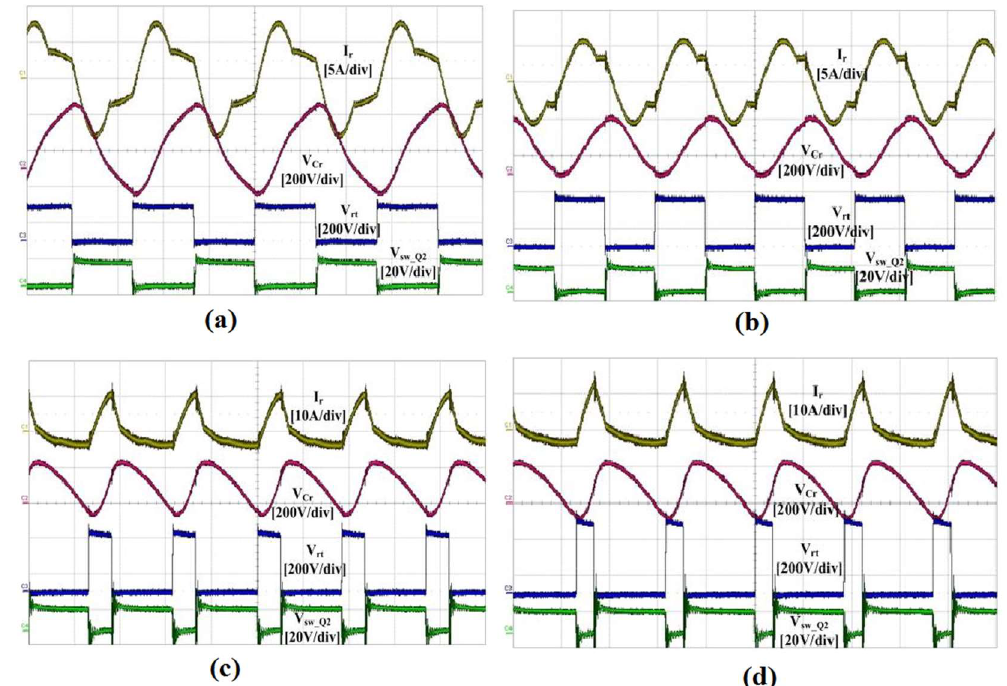
Figure 16. Testing operation of designed converter for wide range variable input voltage. ( a ) V in = 200 V, f s = 74.67 kHz; ( b ) V in = 230 V, f s = 82.31 kHz; ( c ) V in = 300 V, f s = 109.23 kHz; ( d )V in = 400V, f s = 109.23 kHz.